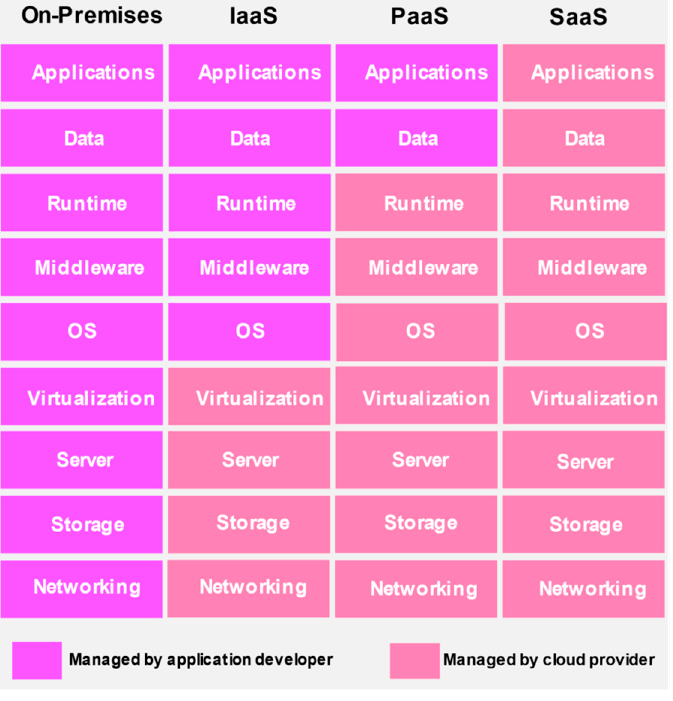
Figure 4. Common cloud service models and their classifications.